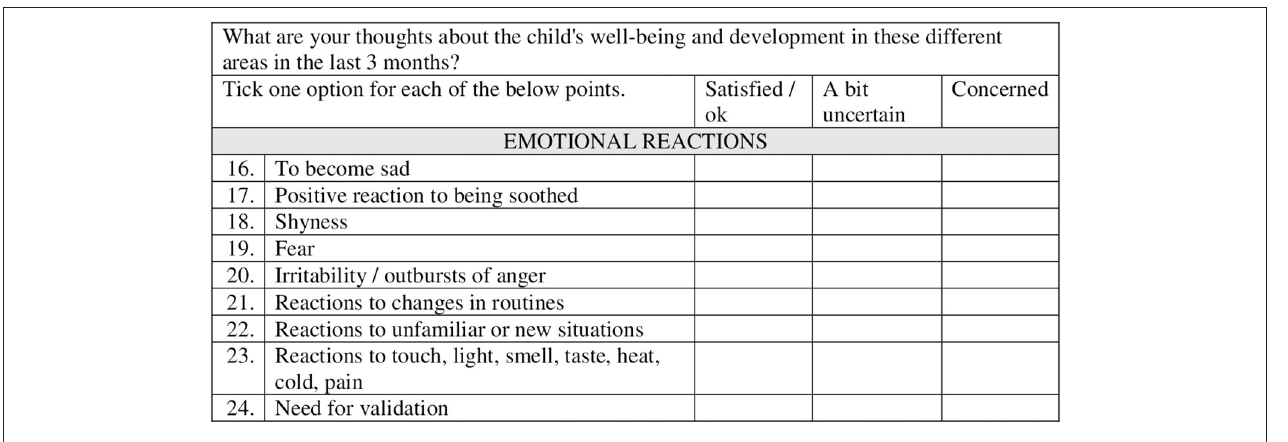
FIGURE 3 | Example of some items in the Early Worry